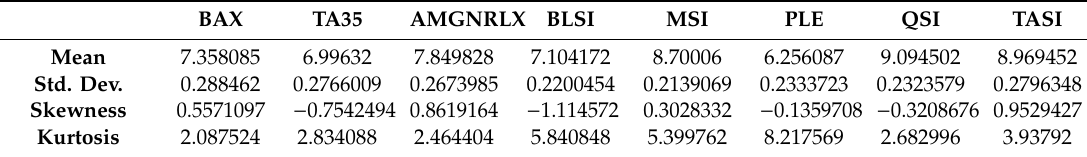
Table 2. Descriptive statistics regarding the returns on the Middle Eastern stock